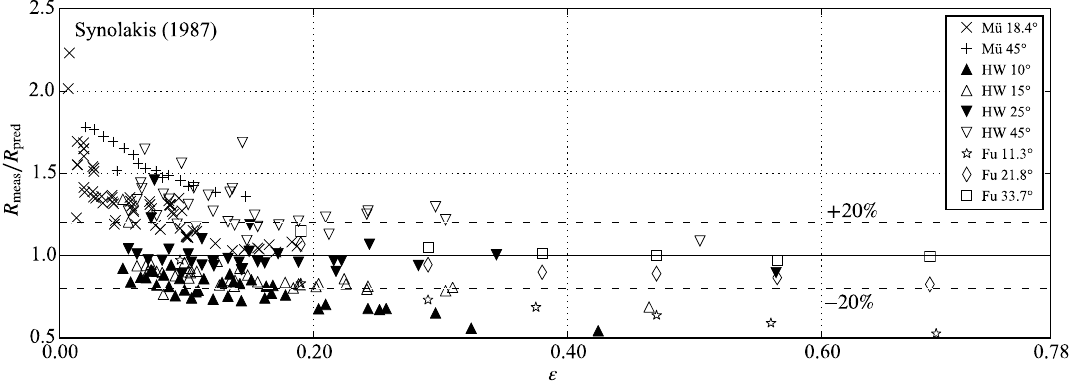
Figure 8. Measured over predicted (Equation (5) by Synolakis [16]) runup height R meas / R pred versus relative wave crest amplitude ε for experiments from data sources from Müller (Mü) [7] (without β = 90 ◦ ), Hall and Watts (HW) [14], and Fuchs (Fu) [20].